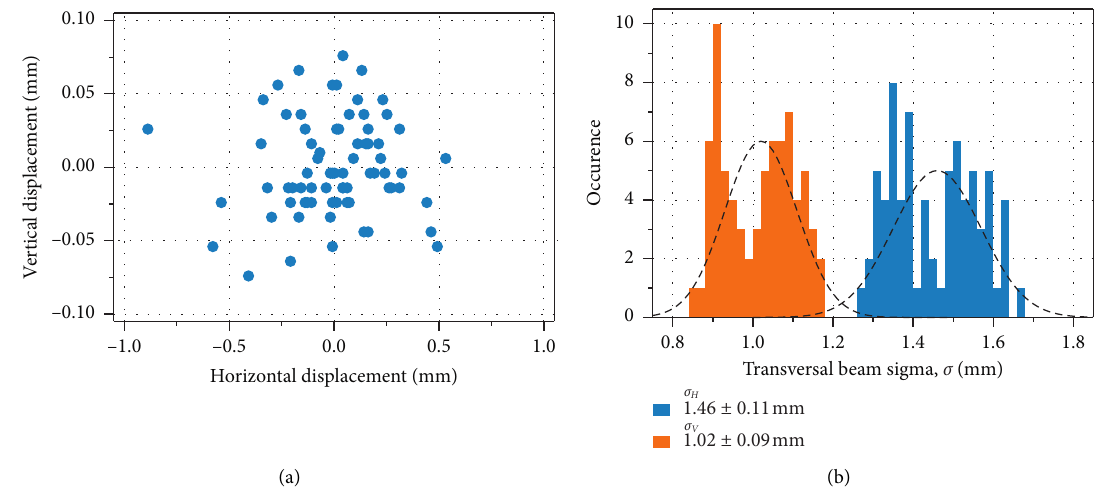
Figure 4: Distribution of the beam position and transversal beam sigma of successive pulses. Displacement of the beam in vertical and horizontal planes for all pulses ( N � 73) on target station 6 showing severe scattering in the horizontal plane (a). Distribution of the transversal beam sigma in horizontal and vertical planes